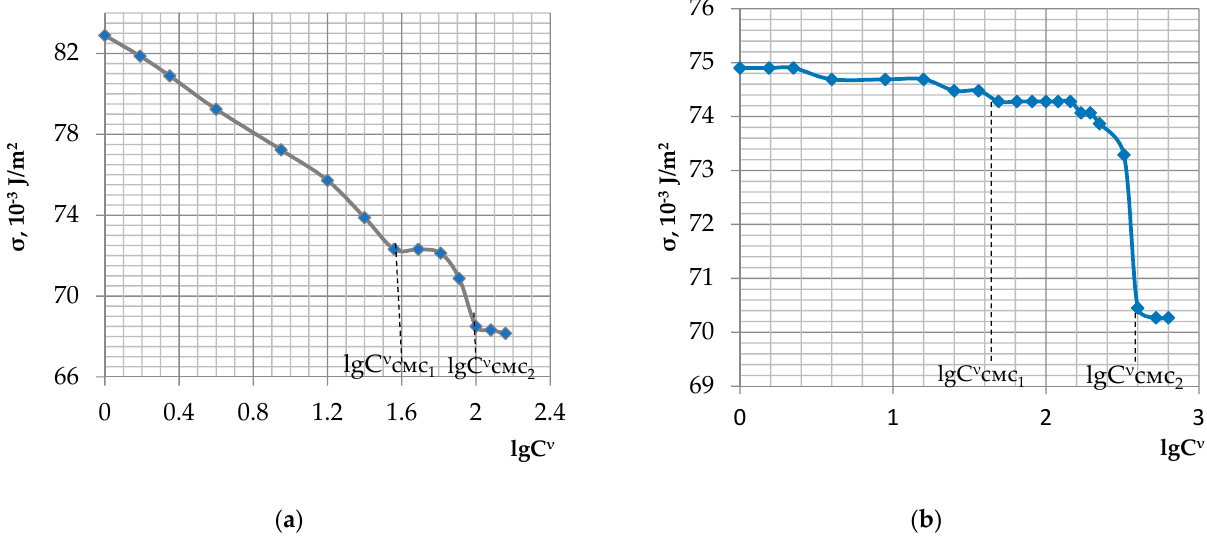
Figure 18. Surface tension isotherms of the plasticizer in σ -lgC ν coordinates: ( a )—in soft water No. 1, ( b )—in hard water No. 2.